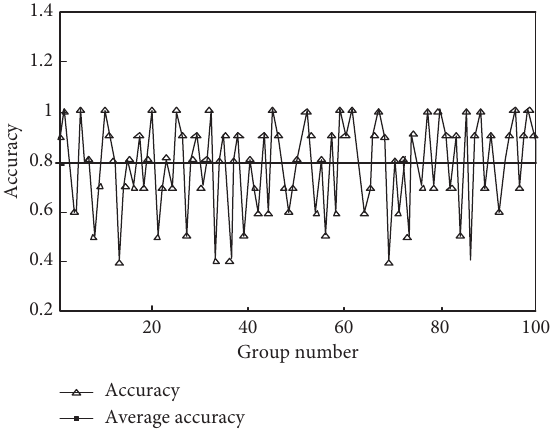
Figure 4: Distribution of user-associated random sampling